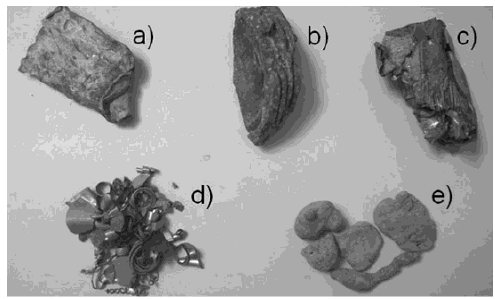
Figure 4. Typical Al scrap used during the charge of a rotary furnace: ( a ) wrought part; ( b ) casting; ( c ) coated packaging; ( d ) turnings and ( e )